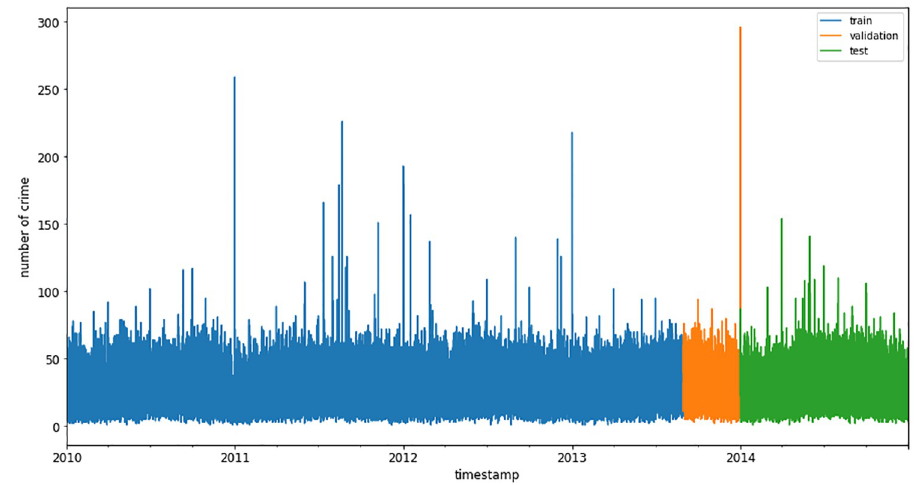
Fig 4. Training, validation, and testing for time-series forecasting.